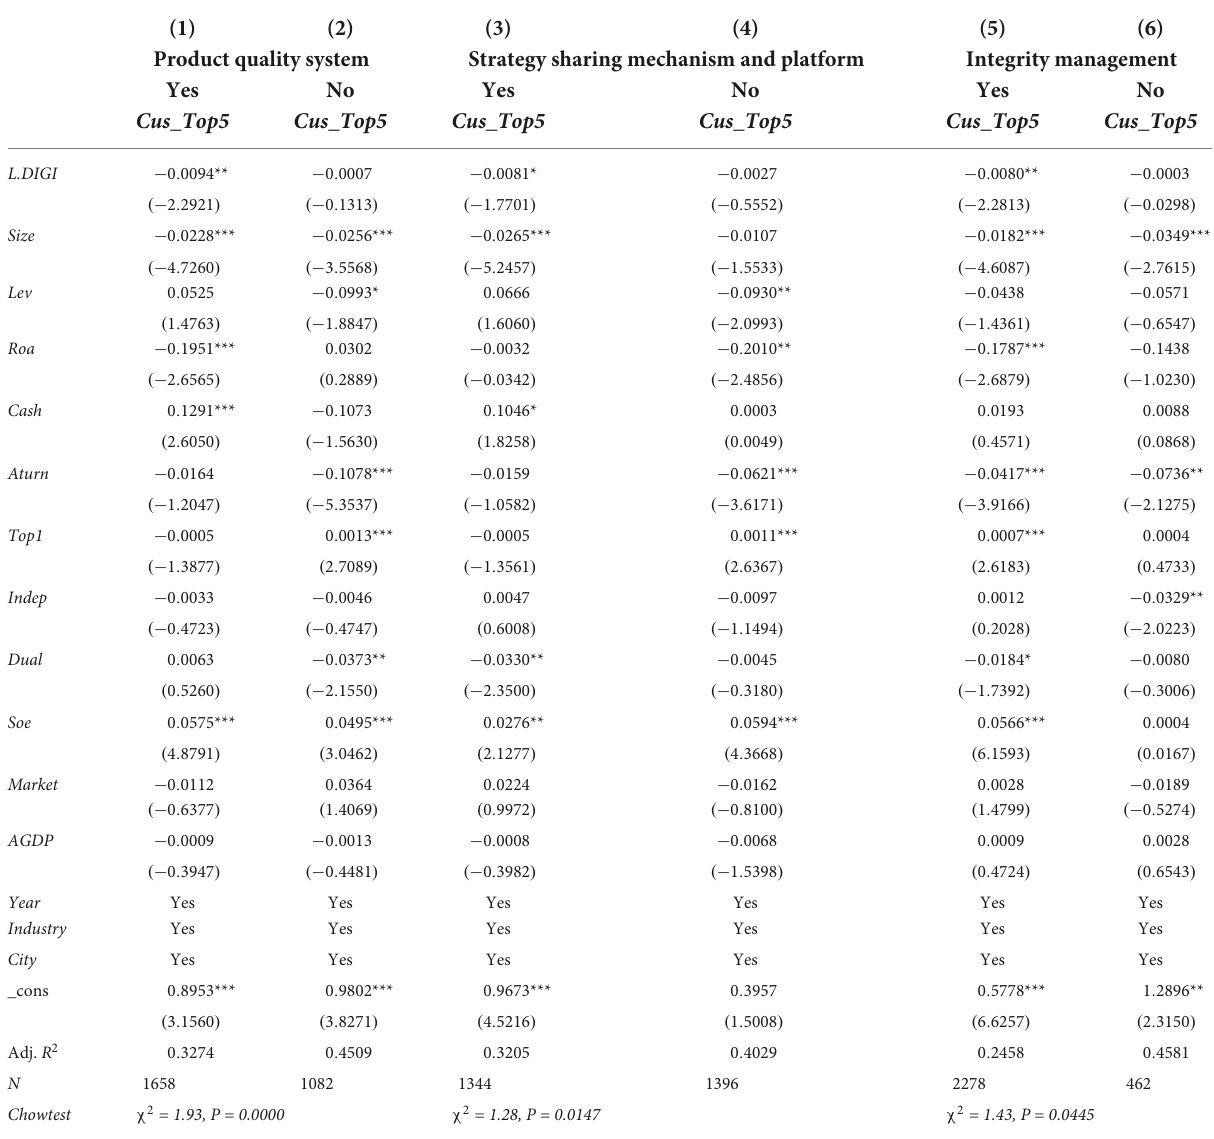
TABLE 11 Heterogeneity test of interaction with customers.